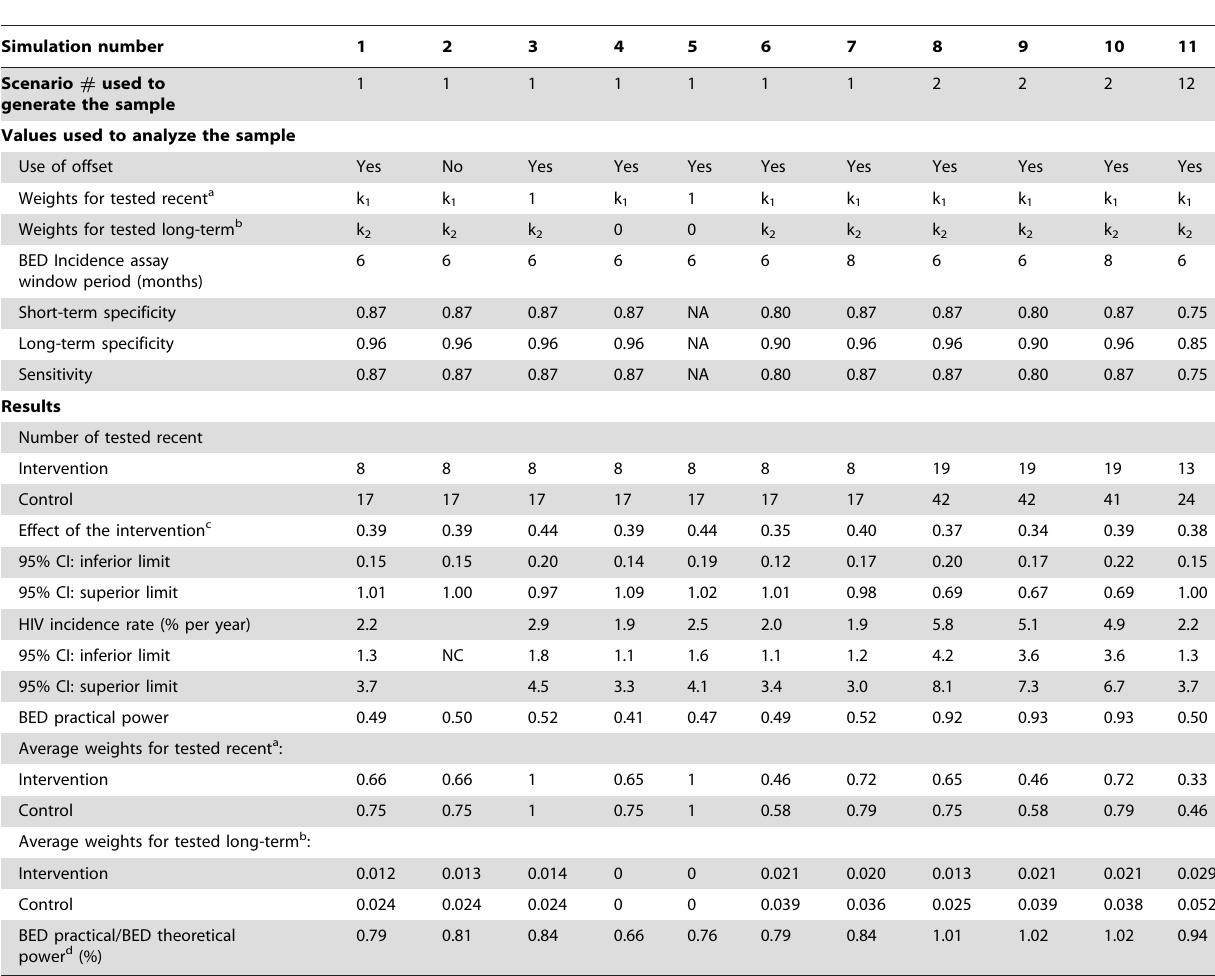
Table 2. HIV incidence rate ratio and BED practical power when using log-linear Poisson regression to analyze simulated samples of young